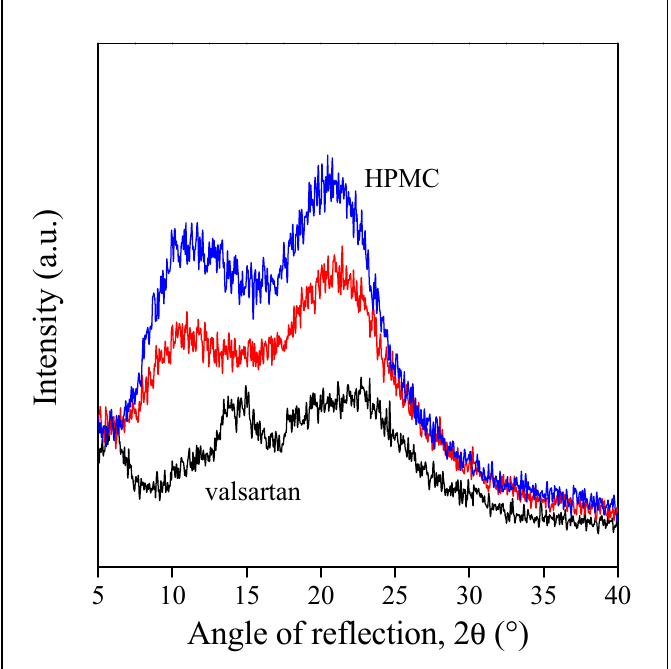
Figure 6. XRD patterns recorded on valsartan, HPMC, and HPMC fibers containing the drug at 20 wt%.